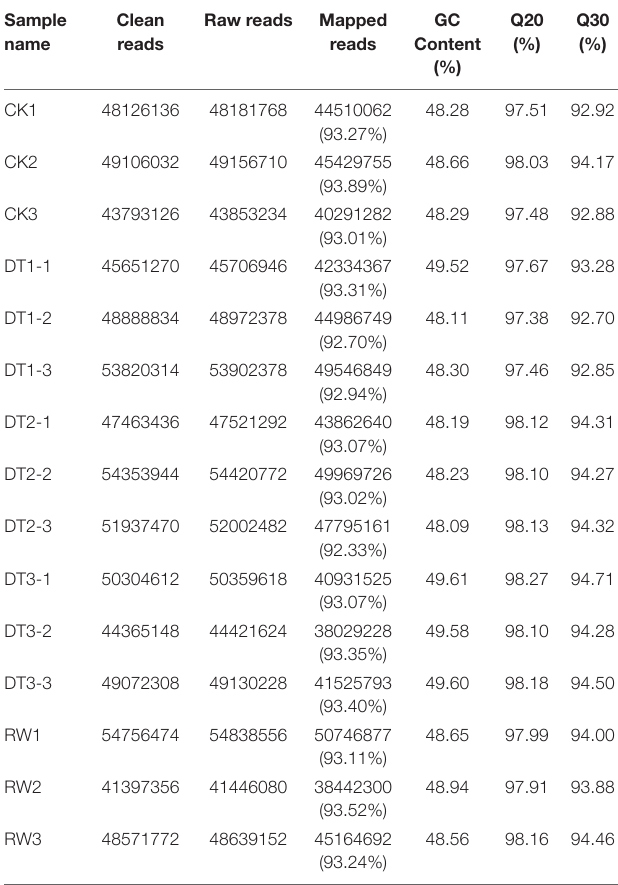
TABLE 1 | RNA sequencing data and corresponding quality control.